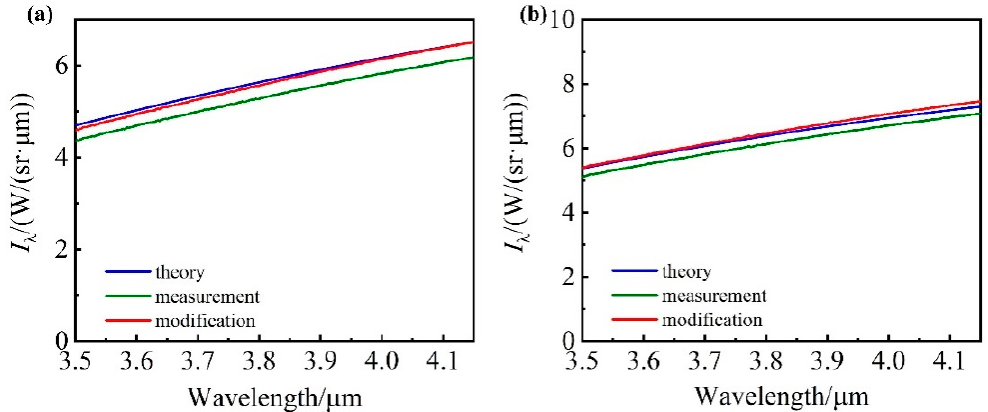
Figure 8. The theoretical curve, the experimental measurement curve, and the corrected curve of the spectral radiation intensity of the blackbody in the 3.5~4.15 μ m band with different test temperatures. ( a ) L = 4.25 m, T = 547 K; ( b ) L = 4.25 m, T = 557 K.